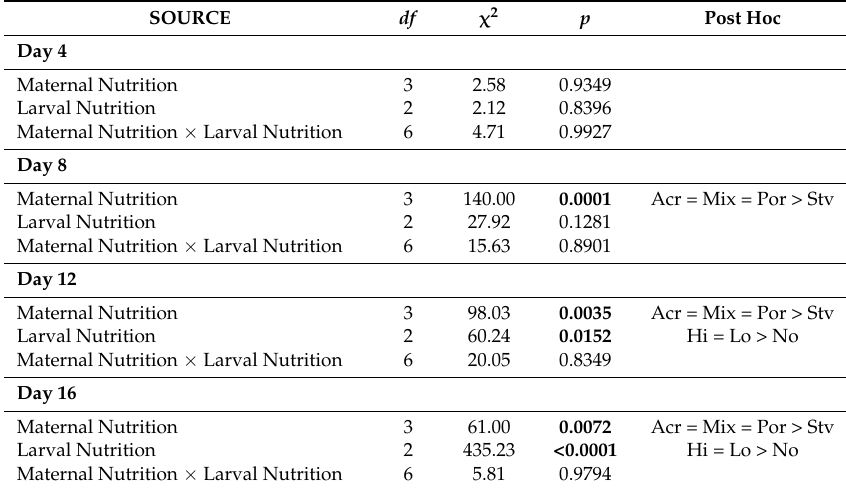
Table 1. Analysis of deviance for binomial generalized linear models (GLMs) testing the effects of maternal nutrition and larval feeding treatments on the proportion of surviving larvae at 4, 8, 12, and 16 days after the onset of the ability of larvae to feed. Hereafter, Maternal Diet: Acr = Acropora , Mix = mixed diet, Por = Porites , Stv = starved; Algal Food Concentration (cells · mL − 1 ): Hi = 10 4 , Lo = 10 3 , No =